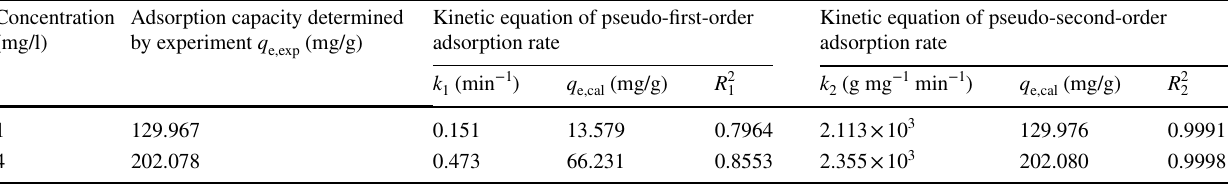
Kinetic equation of pseudo-first-order adsorption